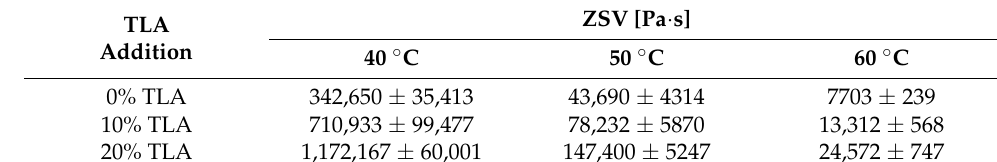
Table 4. Physical properties of TLA-modified binders after RTFOT ageing.